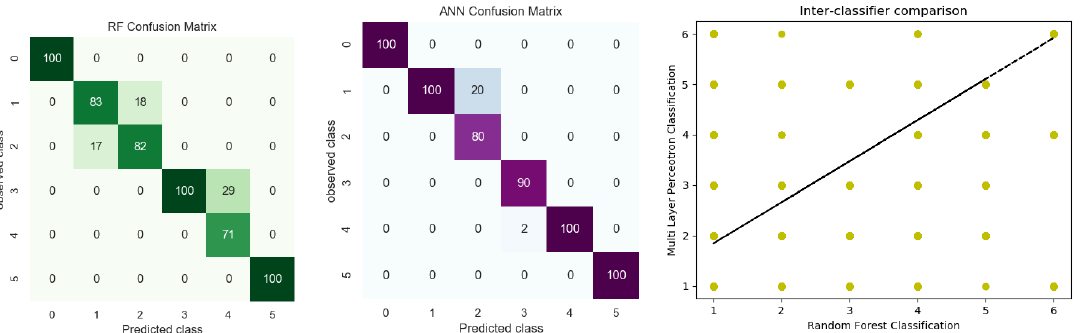
Fig. 3. Confusion Matrix and ANN and RF correlation scatter plot. 1) artificial territories. 2) agricultural territories. 3) forests